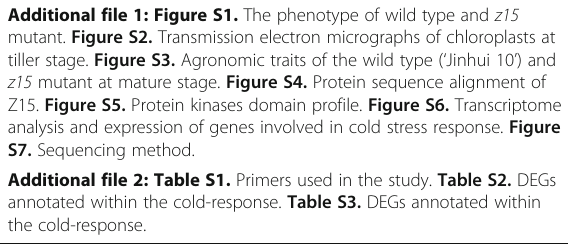
Additional file 1: Figure S1. The phenotype of wild type and z15 mutant. Figure S2. Transmission electron micrographs of chloroplasts at tiller stage. Figure S3. Agronomic traits of the wild type ( ‘ Jinhui 10 ’ ) and z15 mutant at mature stage. Figure S4. Protein sequence alignment of Z15. Figure S5. Protein kinases domain profile. Figure S6. Transcriptome analysis and expression of genes involved in cold stress response. Figure S7. Sequencing method. Additional file 2: Table S1. Primers used in the study. Table S2. DEGs annotated within the cold-response. Table S3. DEGs annotated within the